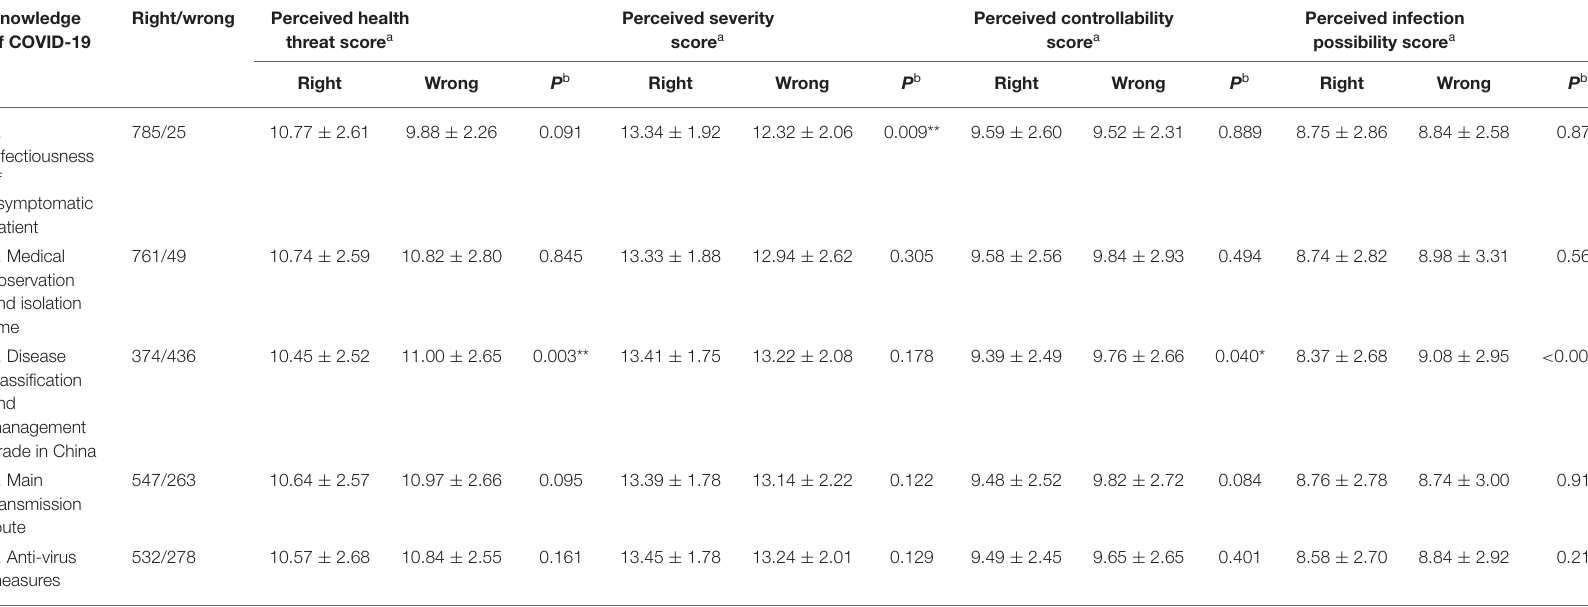
Perceived infection Perceived controllability possibility score a score a